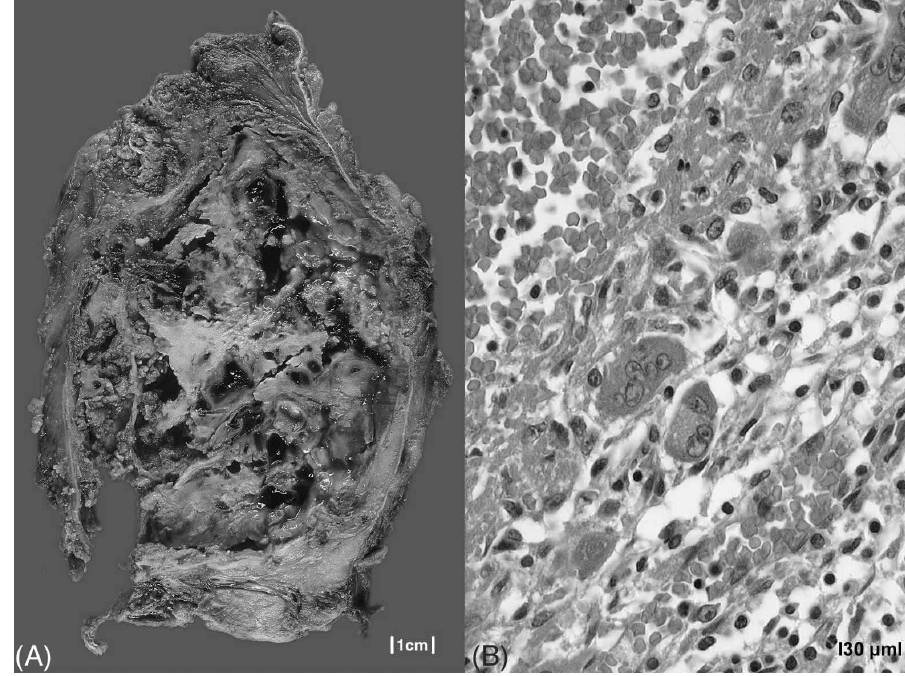
Fig. 3. (A) Macroscopic aspect of the entire tumour with multiple cavities. (B) Typical histological aspect of an